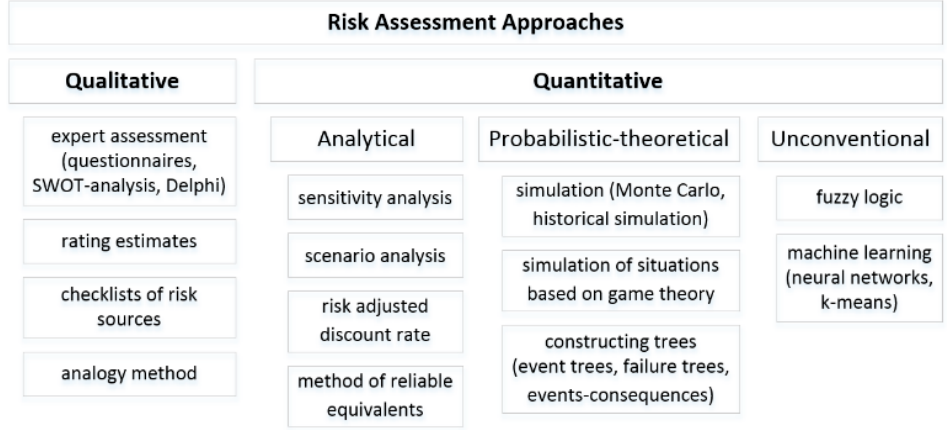
Figure 11. The taxonomy of the risk assessment methods.